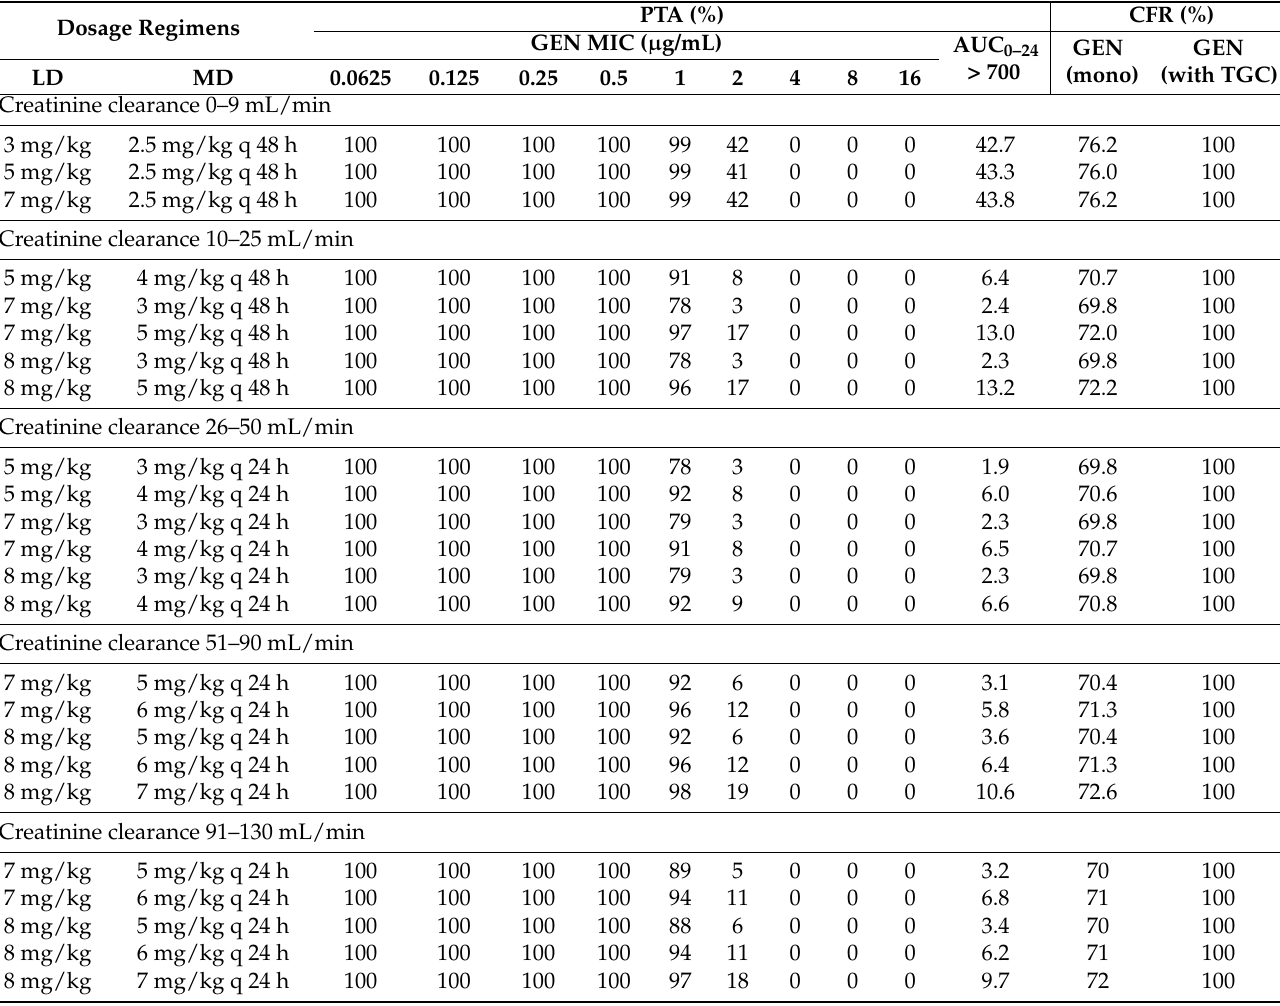
Table 6. The PTA for the different gentamicin regimens in critically ill patients according to kidney function (creatinine clearance) at steady state with targets of C max /MIC > 8 (for efficacy) and AUC 0–24 >